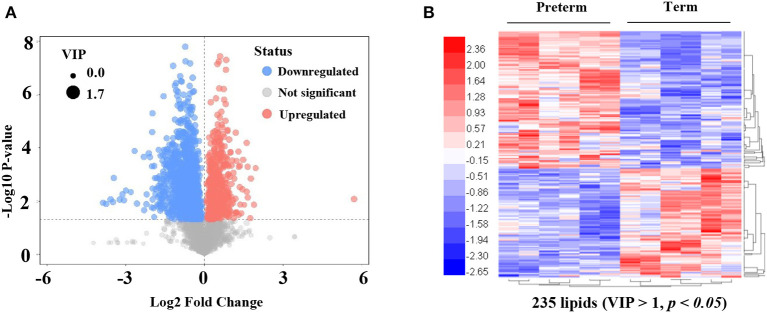
Significantly different lipids in preterm and term human milk. (A) The volcano plot is used for assessing significantly different lipids. Blue dots indicate downregulated lipids in the preterm group; red dots indicate significantly upregulated lipids in the preterm group; gray dots indicate the lipids that were not significantly changed in the preterm group. The size of dots indicates VIP value. (B) The heatmap of hierarchical clustering analysis is used for assessing significantly upregulated and downregulated lipids. Increased and decreased lipid levels are depicted by red and blue colors, respectively. The dendrogram was constructed based on the lipid intensity. VIP, variable importance in projection.